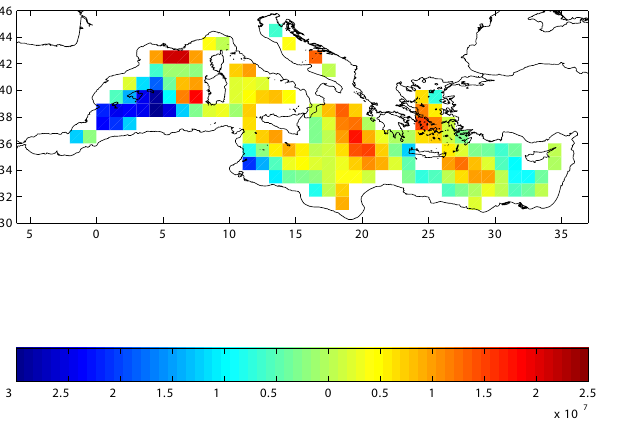
Fig. 3. Mean annual distribution of net short-wave radiation at the sea surface (in W/m 2